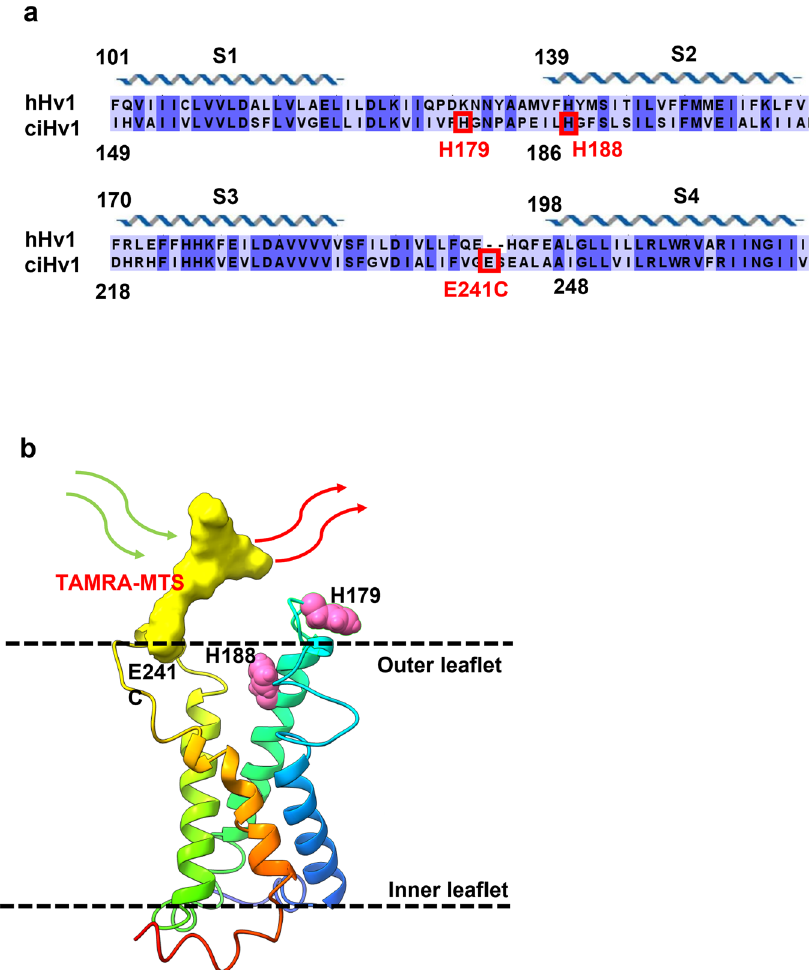
Fig. 2 Sequence alignment and homology model of Ci-Hv1. a Sequence alignment of S1 – S4 voltage-sensing domains for Ci-Hv1 and hHv1. Conserved residues are highlighted with dark blue. Residue numbers are marked above for reference and the helical schematic above the alignment marks the extent of the helices in the homology model of Ci-Hv1, while residues that were mutated to Cys or Ala/Trp are indicated by red rectangles. Sequences included in the alignment are: Ciona intestinalis Hv1 (UniProtKB - Q1JV40), Human Hv1 (UniProtKB - Q96D96), visualized by Jalview 42 . b Homology model of the S1- S4 voltage-sensing domains for Ci-Hv1 based on mHv1 structure (PDB ID: 3WKV). Predicted domains are color coded as follows: S1 (blue), S2 (cyan), S3 (light green), S4 (orange). Membrane boundaries are estimated from superposition with the Kv1.2/2.1 paddle chimera structure where detergents and PCs (phosphatidylcholine) are resolved. TAMRA -MTS attached to E241C is represented in yellow, while the two histidine residues at position 179 and 188 are highlighted by magenta. This panel was created with UCSF Chimera 43 and the fi nal image rendered with ChimeraX 44